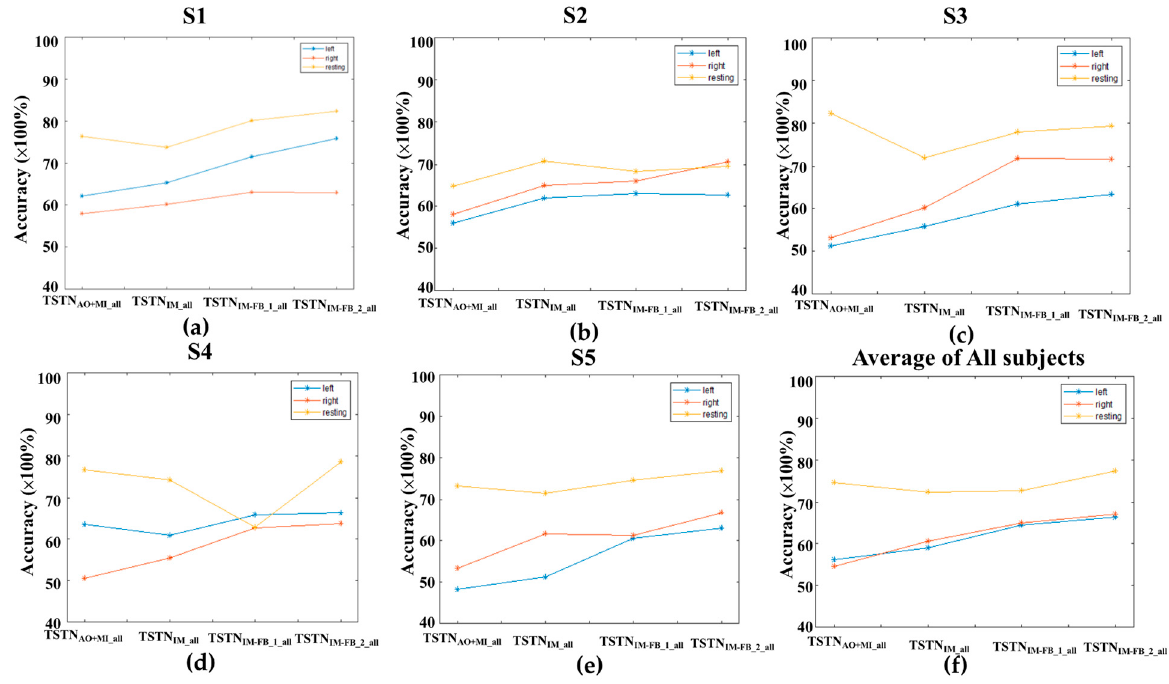
Figure 6. The detected accuracies by applying the TSTN AO+MI_all , TSTN MI_all , TSTN MI-FB_1_all , and TSTN MI-FB_2_all to the MI (without feedback), first MI-FB, second MI-FB, and third MI-FB datasets in ( a ) S1, ( b ) S2, ( c ) S3, ( d ) S4, ( e ) S5 and ( f ) the average of all the five subjects.